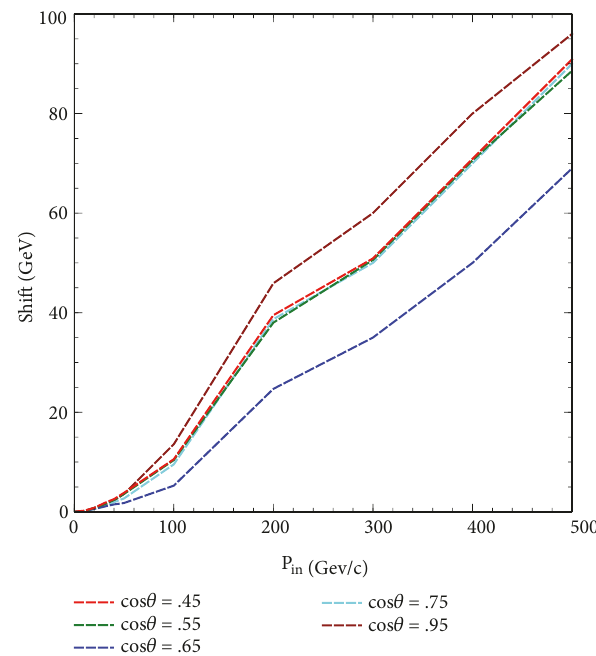
Figure 6: Shift in the mean of the reconstructed momentum as a function of the input momentum.